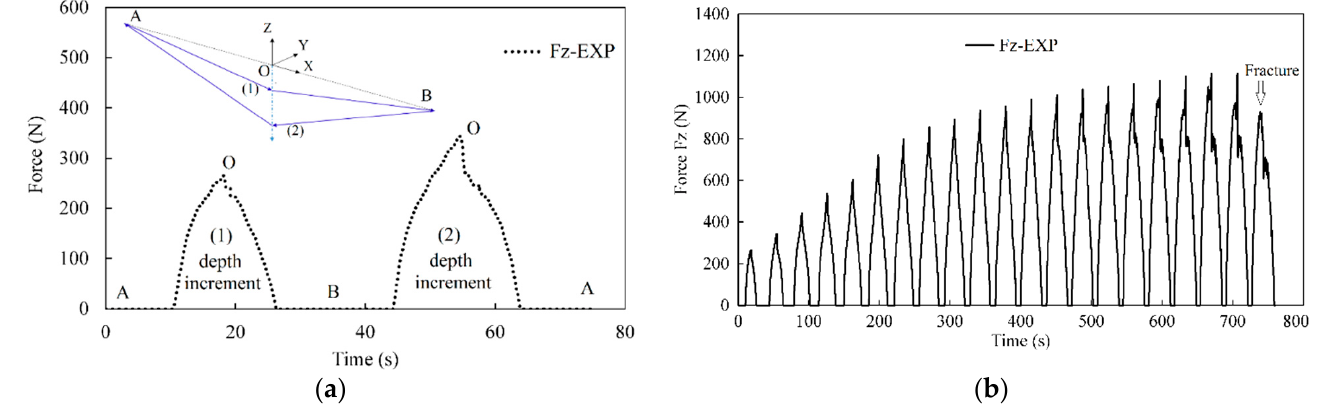
Figure 4. ( a ) Forming force Fz in the first and second depth increment. ( b ) Forming force Fz in whole forming process.